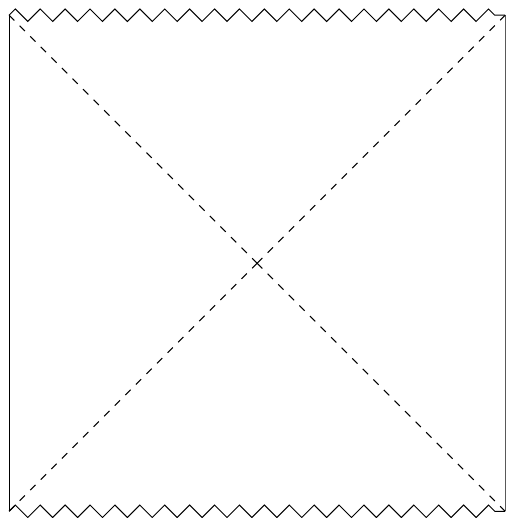
Figure 2. The Penrose diagram of an eternal AdS-Schwarzschild black